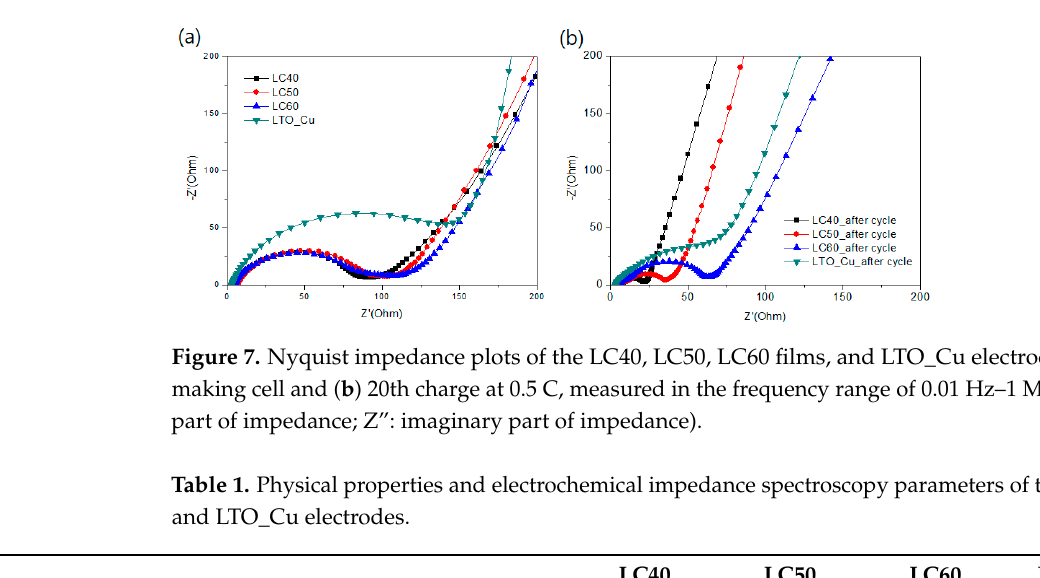
Figure 6. Capacity and coulombic efficiency curve of the ( a ) LC40 film, ( b ) LC50 film, ( c ) LC60 film,